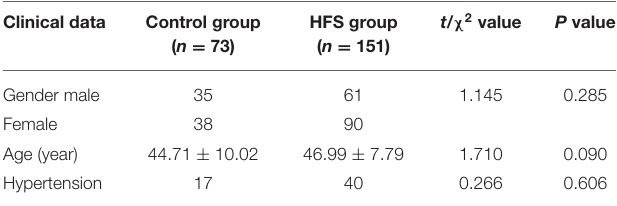
TABLE 2 | Comparative analysis table between the hemifacial spasm (HFS) group and the control group ( n , x ± s ). Clinical data